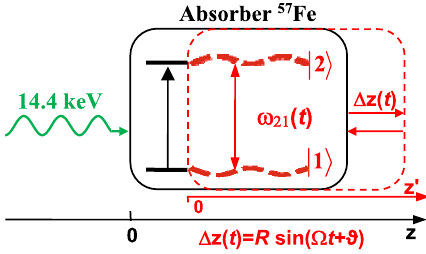
Figure 1. (Color online) Energy scheme of 14.4-keV photon propagation through the vibrating absorber used in the experiment 37 . Recoilless 14.4-keV photons ( λ 0 = 2π c / ω 0 ≈0.86 Å) resonantly interact with transition 1 2 of 57 Fe nuclei when propagating through the single-line 57 Fe absorber. They are resonantly absorbed | � ↔ | � in motionless absorber (black lines). Harmonic vibration of the absorber as a whole (piston-like vibration) with circular frequency Ω, amplitude R , and initial phase ϑ along the photon propagation direction (marked in red) 1 2 leads to periodic temporary variation in transition frequency ω 21 ( t ) (dashed red curves) due to the | � ↔ | � Doppler effect. It modifies the interaction of photon with absorber and can result in AIT (see Fig. 2 and text). The axis z labels the laboratory reference frame, red axis z ’ labels reference frame of the vibrating absorber, and Δ z = z−z